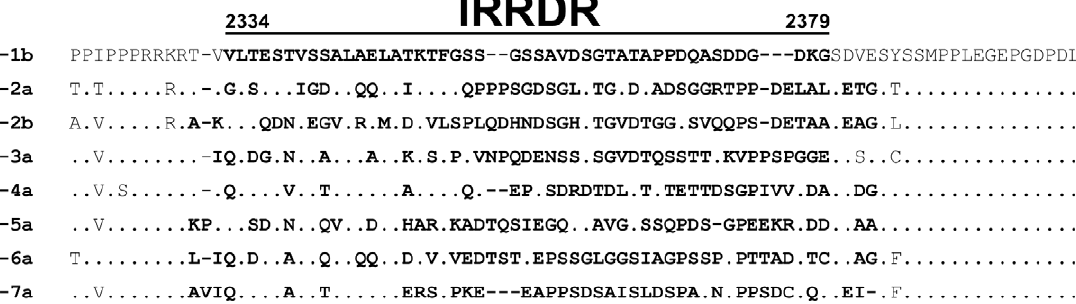
Figure S1 Sequence alignment of the core protein of HCV-2a isolates. Core protein sequences (aa 1 to 120) of HCV- 2a obtained from SVR and non-SVR patients are aligned. Prototype sequence of HCV-J6 [18] is shown on the top. The numbers along the sequence indicate the aa positions. Dots indicate residues identical to those of the prototype sequence. (TIF) Figure S2 Sequence alignment of the core protein of HCV-2b isolates. Core protein sequences (aa 1 to 120) of HCV- 2b obtained from SVR and non-SVR patients are aligned. Prototype sequence of HCV-J8 [19] is shown on the top. The numbers along the sequence indicate the aa positions. Dots indicate residues identical to those of the prototype sequence. (TIF) Table S1 Univariate and multivariate analyses for identification of independent predictive factors for RVR in HCV-2a- and -2b-infected patients treated with PEG-IFN/RBV therapy. Table S2 Positive and negative predictive values (PPV and NPV) of NS5A polymorphic factors for SVR predic- tion.